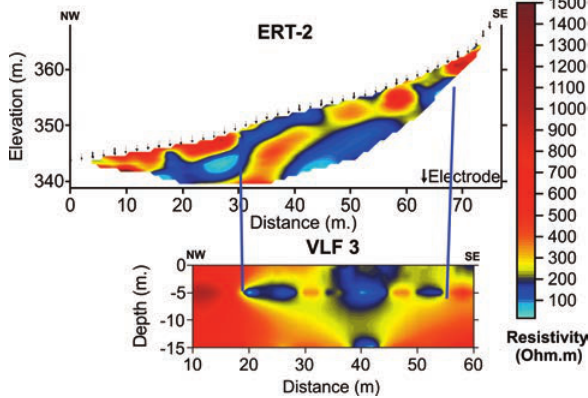
Figure 6. Comparison of resistivity sections generated from the in- version of the ERT-2 data values (11th iteration, RMS: 2.74%) and the VLF-3 data inversion with Inv2DVLF. It is clear that both the techniques have produced similar